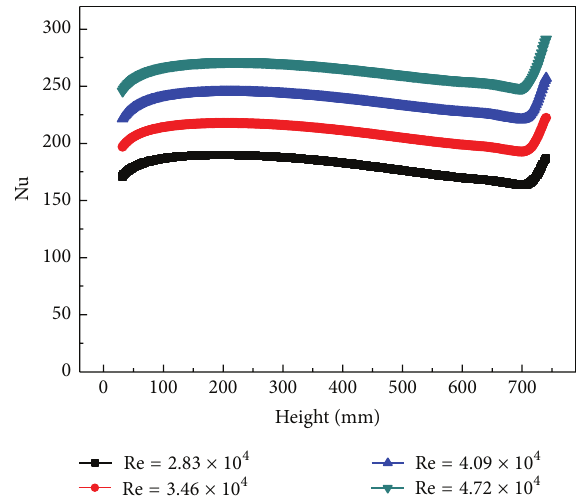
Figure 13: Nusselt number along the channel with different Reynolds